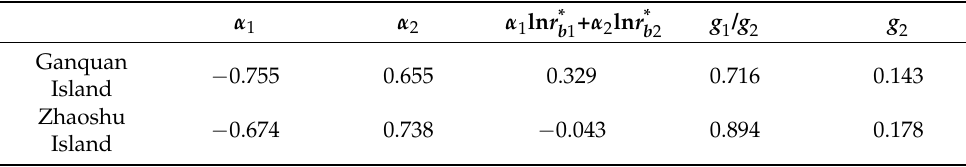
Table 3. Estimated Parameters of Two